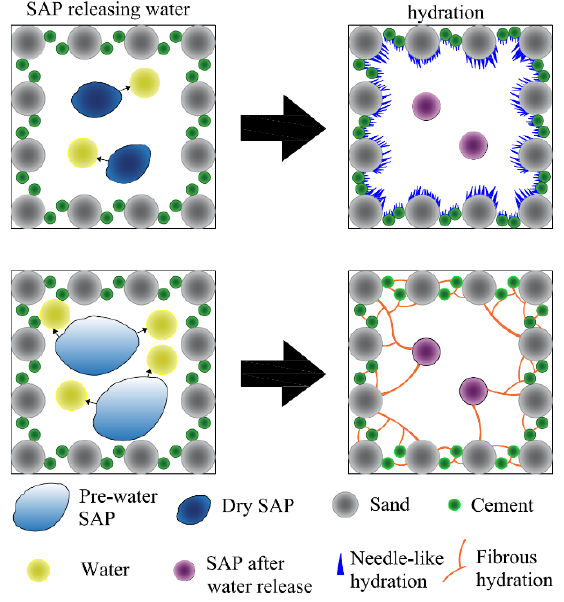
Figure 7. Hydration mechanism of SAP internally cured concrete.